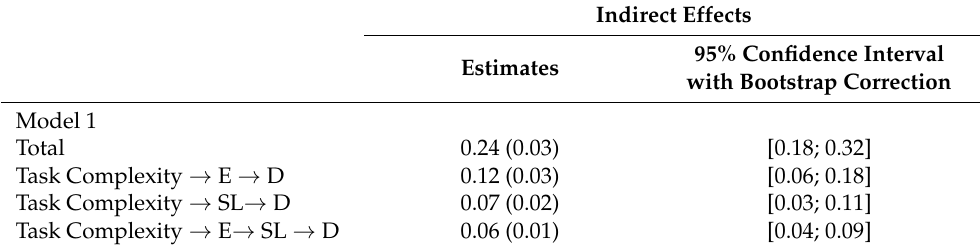
Table 7. Indirect effects of model 1.